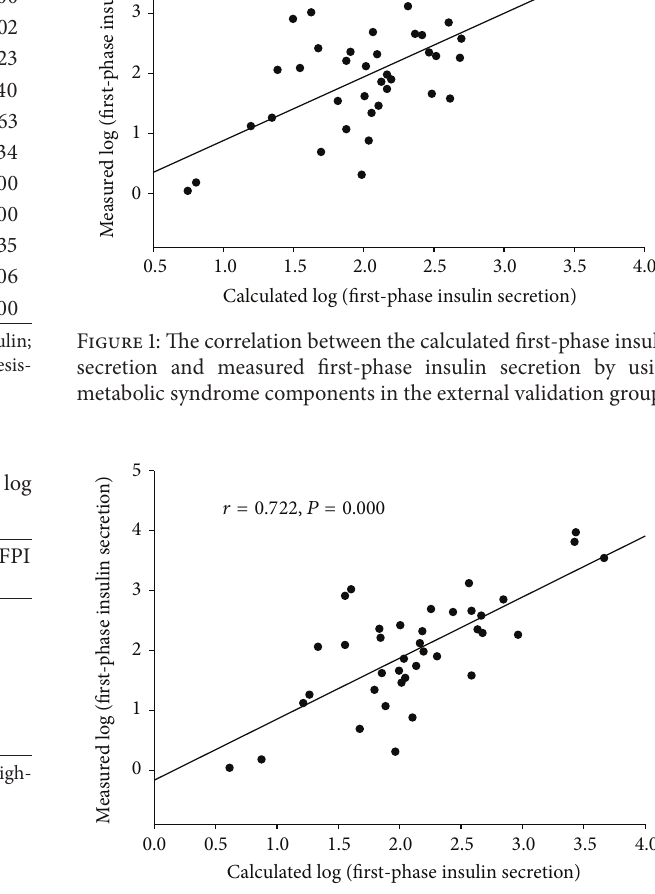
Figure 2: The correlation between the calculated first-phase insulin secretion and measured first-phase insulin secretion by using metabolic syndrome components and fasting plasma insulin in the external validation